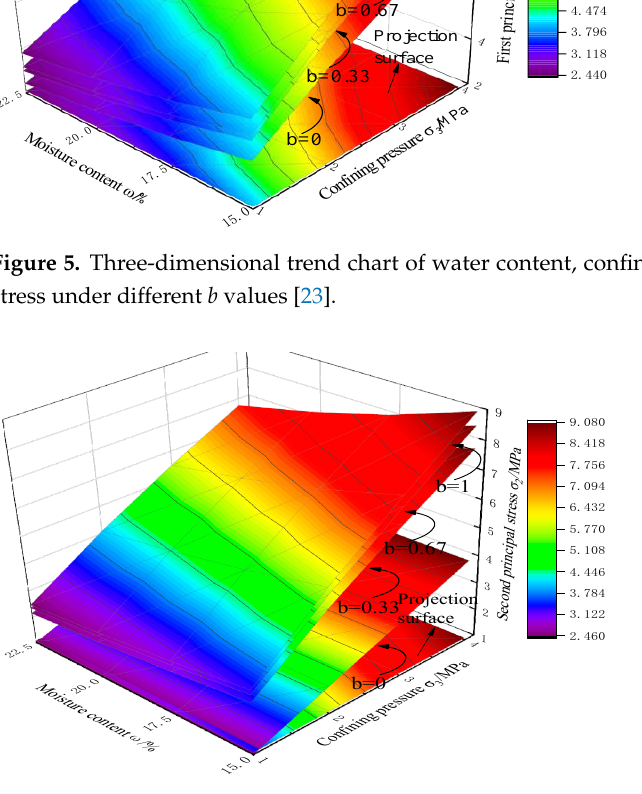
Figure 6. Three-dimensional trend chart of water content, confining pressure, and intermediate principal stress under different b values [23].